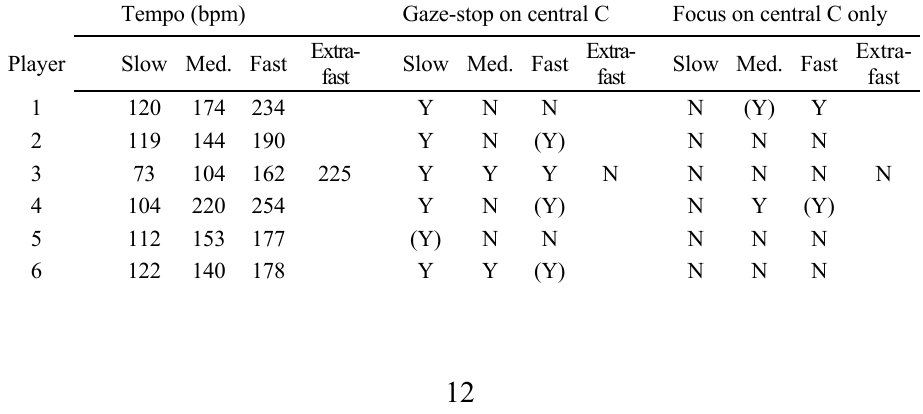
Table 3. Characterization of gaze-fixations strategies for each player according to performance speed. ‘Gaze-stop on central C’ corresponds to a fixation on the central note of the keyboard, which is repeated twice in between extreme pitches. ‘Focus on central C only’ refers to players who only fix their gaze on the central note of the keyboard, while playing all of the exercise. ‘Y’ indicates that performers use this technique, ‘N’ that they do not have recourse to it. ‘(Y)’ indicates partial use through the entire exercise. ‘N’ in both categories corresponds to gaze-shifts from one extreme to the other, the gaze never fixing the central note except for the very beginning and end of the